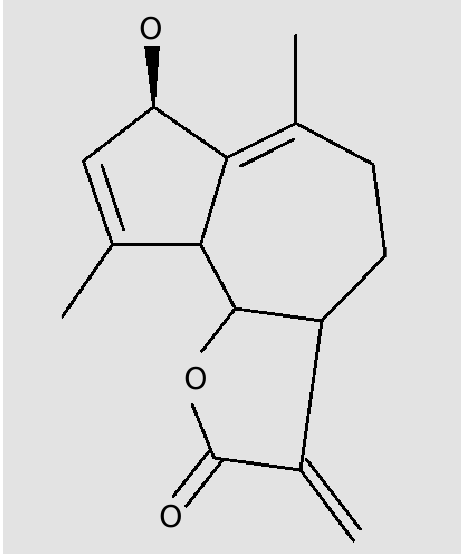
Figure 2. Structure of the dehy- droleucodine, the active prin- ciple of Artemisia douglasiana